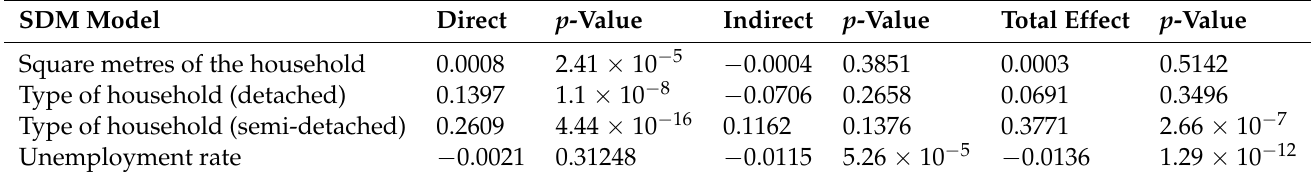
Table 3. SDM model results.